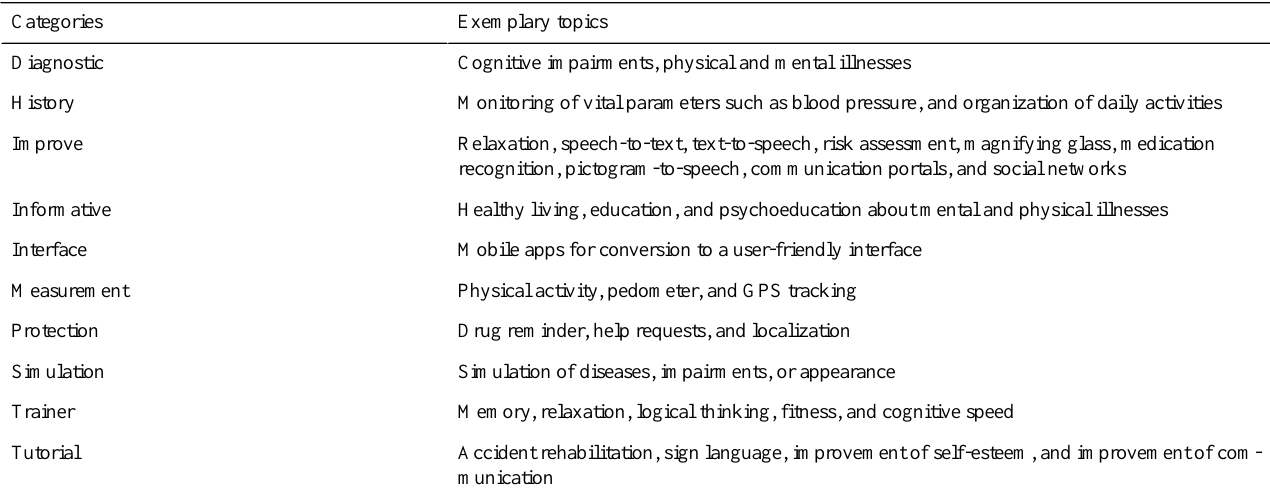
Simulation of diseases, impairments, or